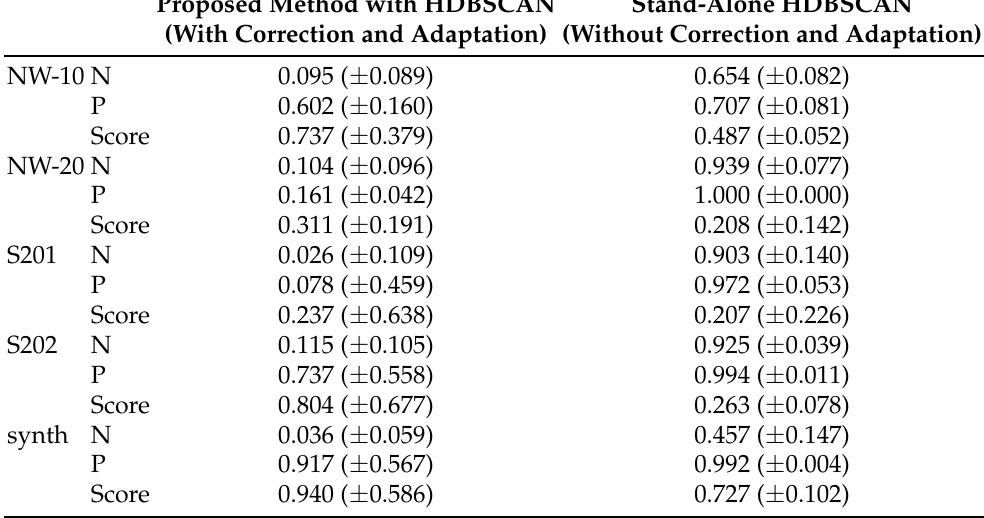
Table 4. Average quality measures of the proposed method executed with HDBSCAN base model, adaptation of the base model and correction model, and average quality measures of the stand-alone HDBSCAN method (average of runs for different parameter values).